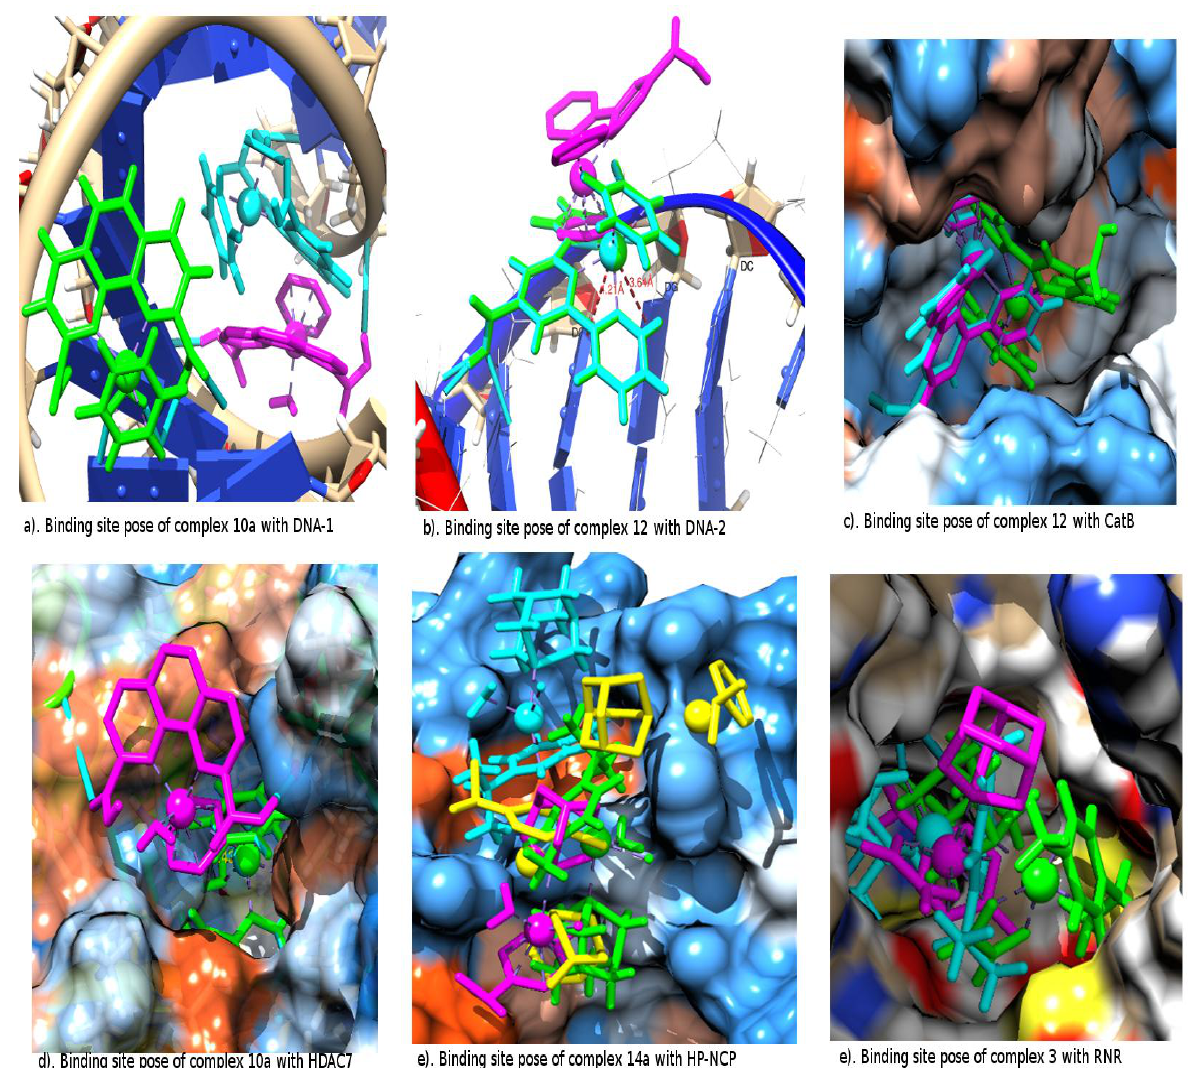
Figure 2. The receptor binding site interaction of the selected best binding metallocompounds from Autodock (magenta), unconstrained Molegro (cyan), constrained (green) and the experimental crystal structures